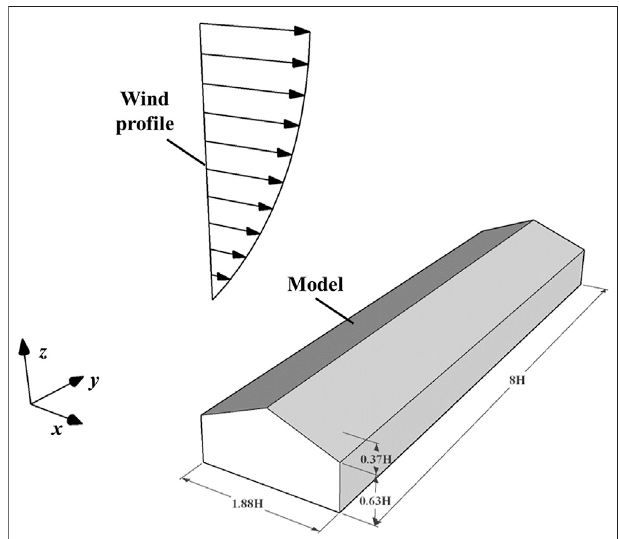
FIGURE 11 | Pitched roof building model in the wind tunnel experiment ( H = 0.063